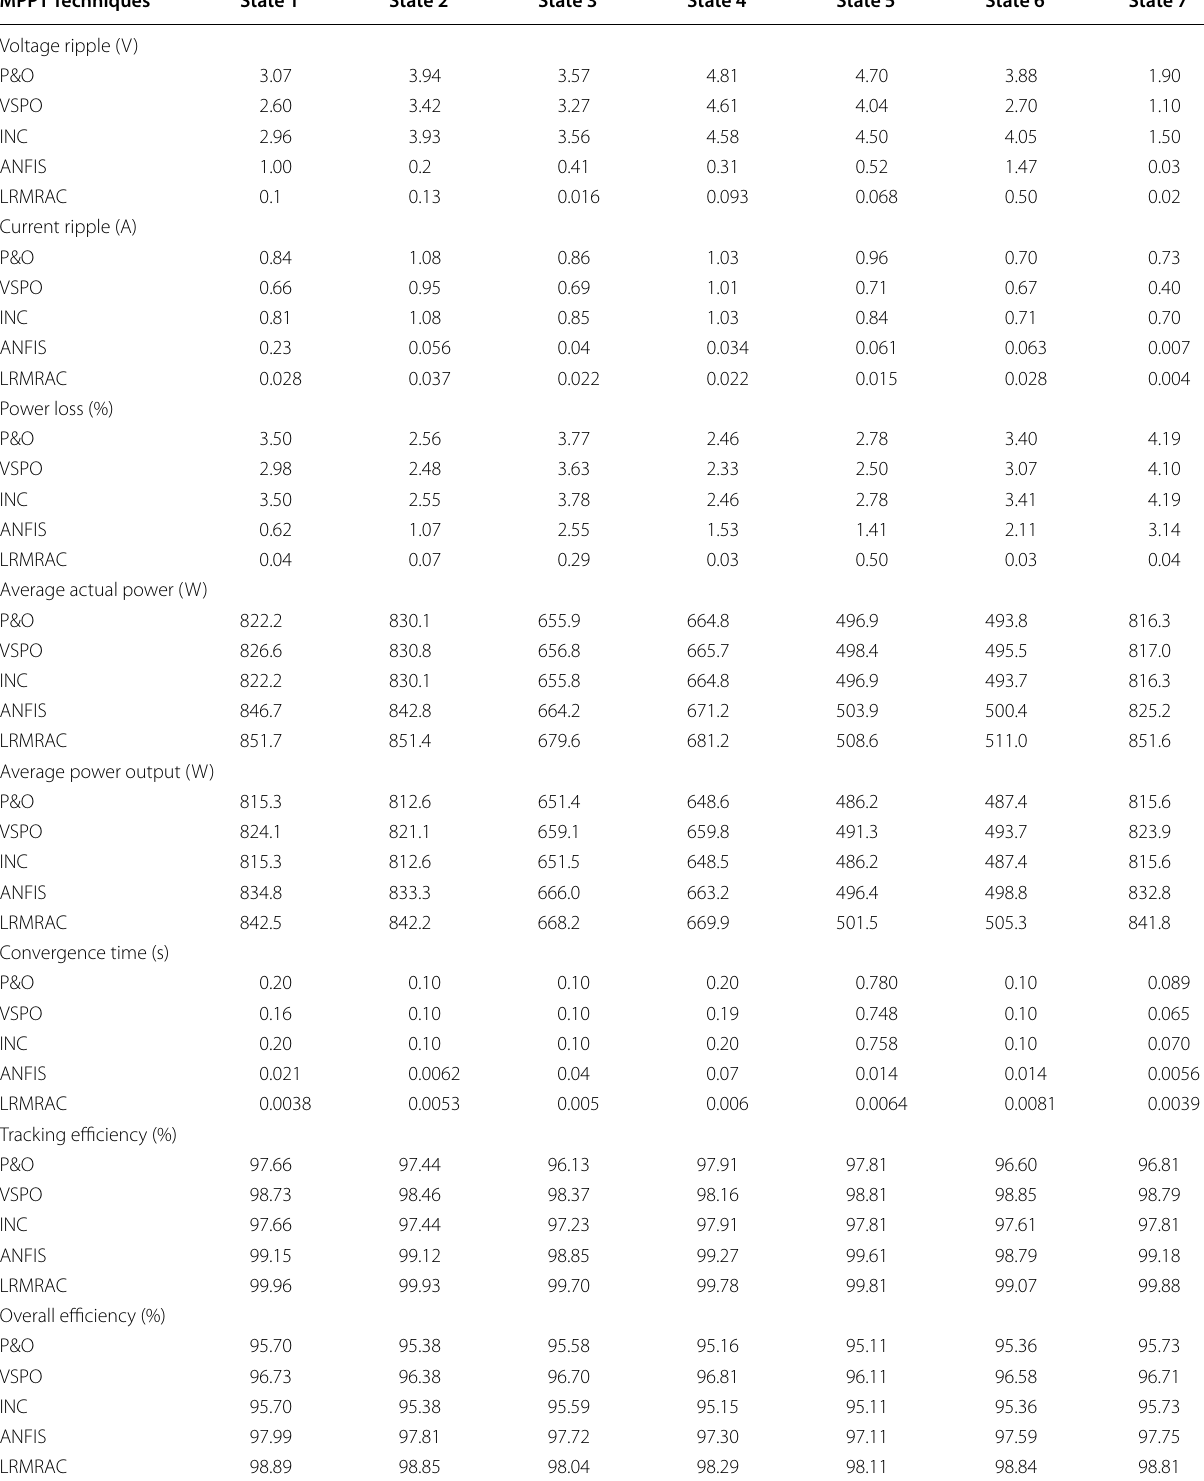
Table 2 Detail comparative analysis of the five approaches with 7